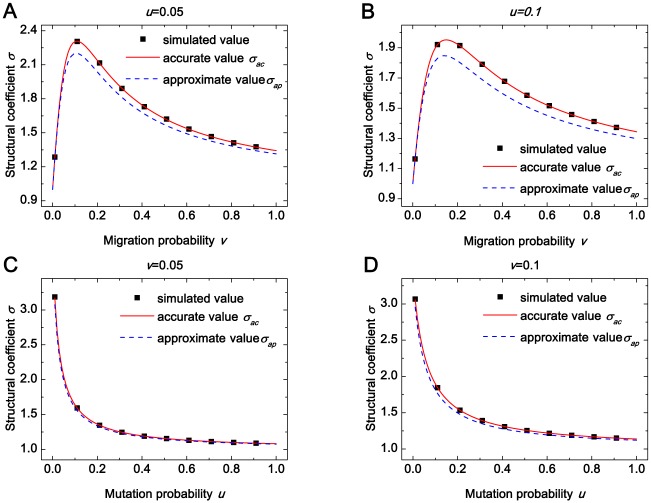
The comparison of the accurate structural coefficientσac, the approximate one σap, and the one from the Monte Carlo simulation across various mutation probabilities (u) and various migration probabilities (v).(A)-(D) shows that σac (solid line) is in agreement with the one from Monte Carlo simulations (square, averaged over 109 generations) for all v and all u, and σap (dashed line) is in line with the one from the Monte Carlo simulation (square, averaged over 109 generations) for low v and has a significance difference from the one from the Monte Carlo simulation (square, averaged over 109 generations) for high v. Parameters: N = 100, M = 19.